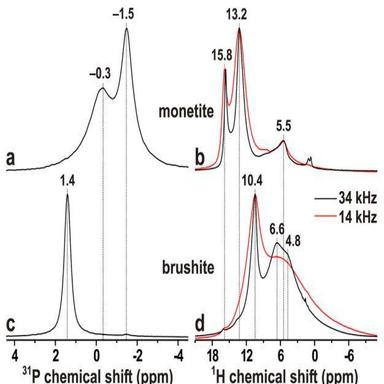
MAS NMR spectra recorded from (a, b) monetite and (c, d) brushite powders. The left panel displays 31P spectra recorded at 14.00 kHz MAS. The right panel contrasts 1 H NMR results obtained at MAS rates of 34 kHz (black traces) and 14.00 kHz (red traces). (For interpretation of the references to colour in this figure legend, the reader is referred to the Web version of this article.)